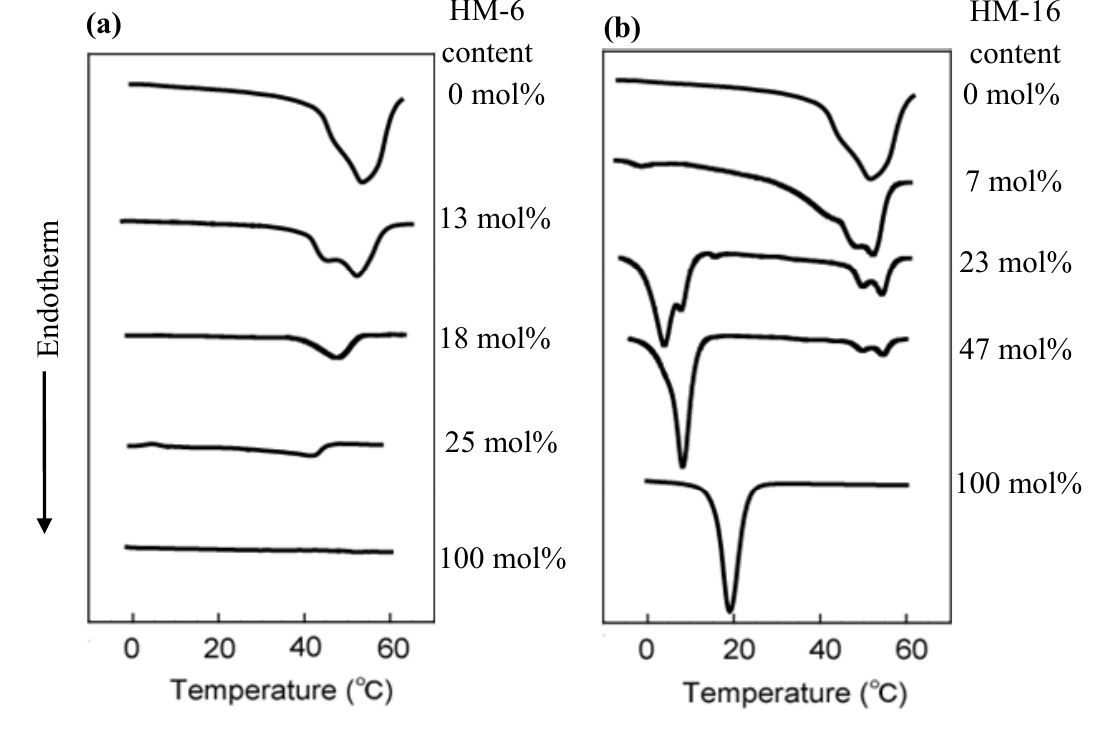
Figure 7. Melting peaks of ( a ) PHS/M-6 and ( b ) PHS/M-16 with various monomer